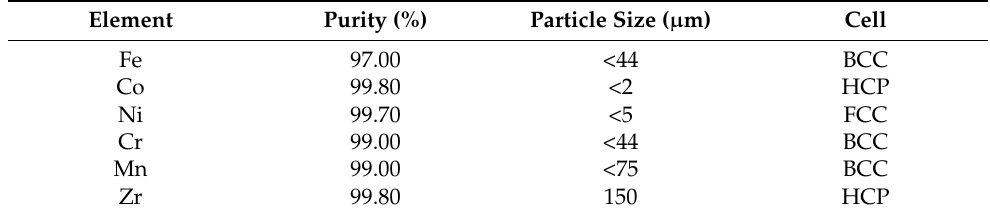
Table 1. Composition of the metal powders (BCC: body centred cubic; FCC: face centred cubic; HCP: Hexagonal close packed